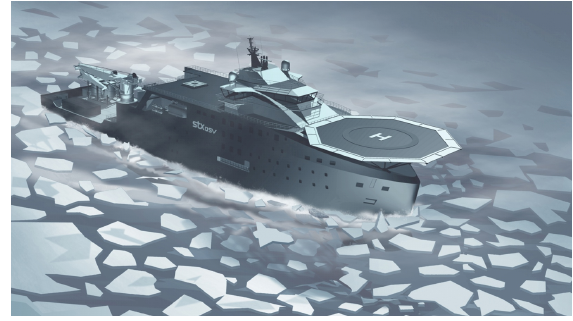
Figure 1: An illustration of the CIVArctic vessel (Source: http://www.sintef.no/Projectweb/